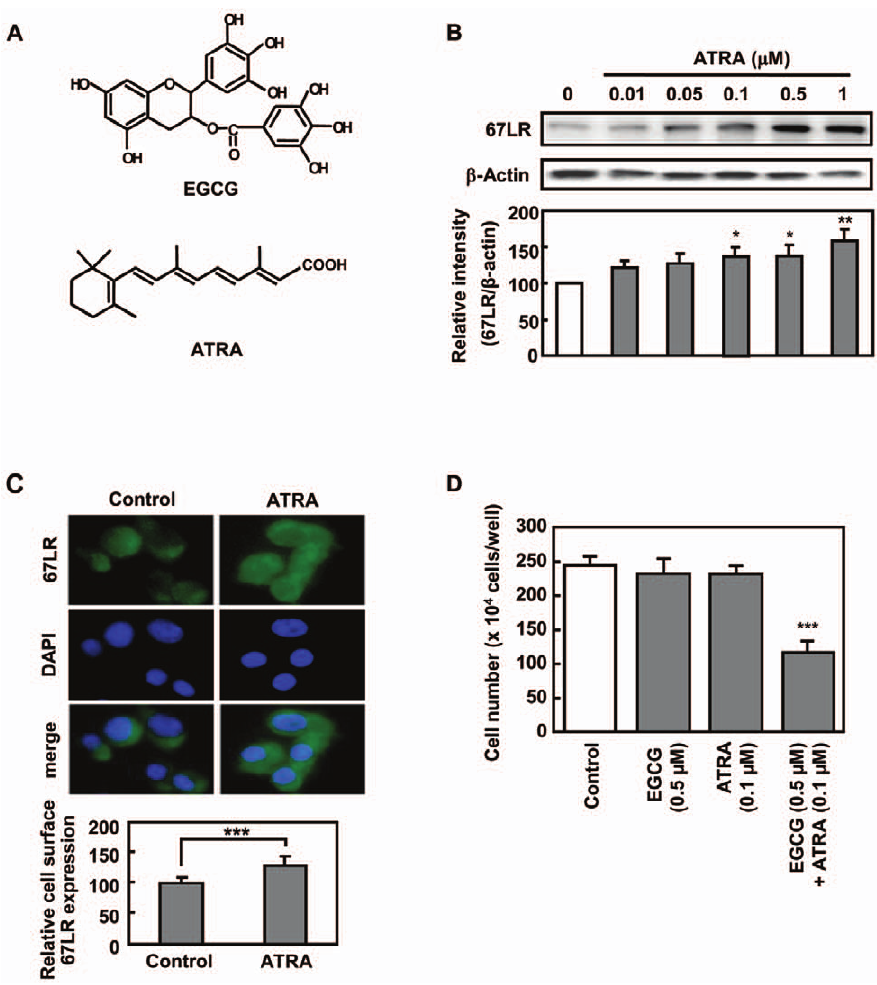
Figure 1. ATRA enhances the expression of 67LR and cell growth inhibitory activity of EGCG. A ) Structure of EGCG and ATRA. B ) 67LR protein levels in B16 cells exposed to the indicated concentrations of ATRA for 48 h were analyzed by Western blot analysis. Levels of 67LR expression were detected with anti 67LR serum, and were normalized to b -Actin. Band intensities were quantified using NIH Image J software. C ) Anti-67LR antibody conjugated with Alexa Fluor 488 (1 mg/ml) was used at a dilution of 1:100. Photographs were taken under Keyence BZ-8001 fluorescence microscope. D ) Cells were counted after treatment with or without 0.5 m M EGCG and/or 0.1 m M ATRA in DMEM supplemented with 1% FCS for 48 h and 96 h each. Cell proliferation was evaluated by counting the number of cells using a Counlter Counter. Data shown are means 6 S.D. for three samples. Data containing asterisk marks are significantly different from the values in control at *** p , 0.001.